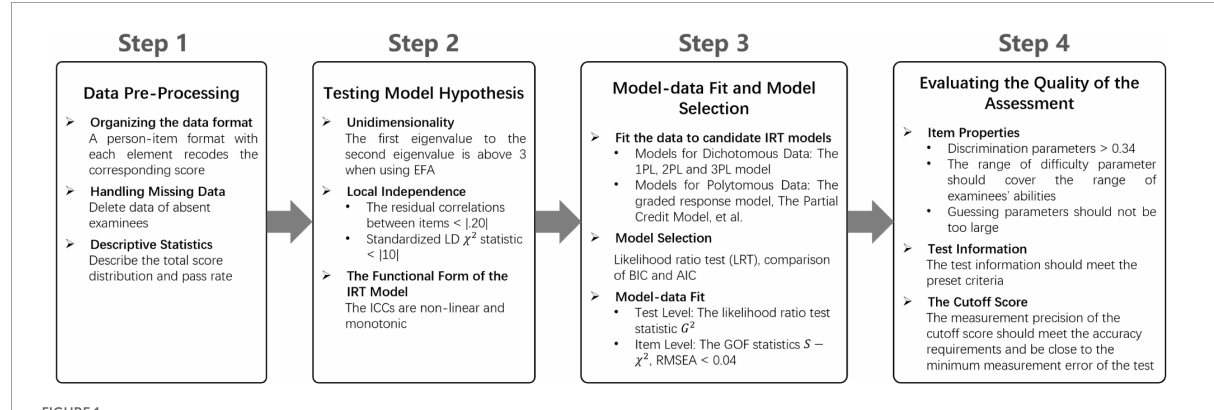
FIGURE1 The steps of using psychometric methods to evaluate the quality of medical education assessments.